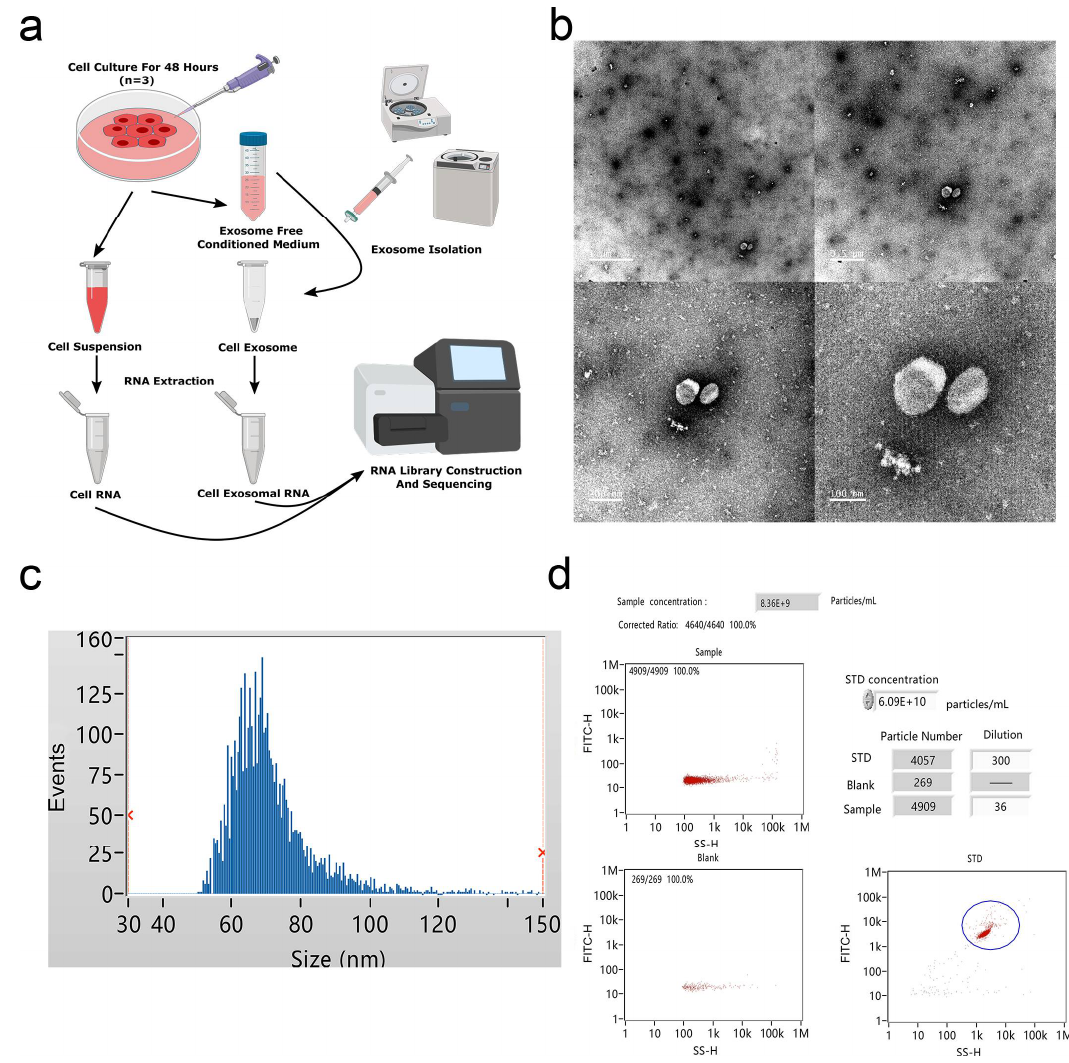
Figure 1. Identification of bovine adipocytes-derived exosomes. ( a ) Exosome collection procedure from bovine adipocytes conditioned medium. ( b ) Transmission electron microscope (TEM) images of exosome isolations using ultracentrifugation. Scale bar = 1 µ m, 0.5 µ m, 200 nm, and 100 nm. ( c ) The size distribution of the purified exosomes was detected using Flow NanoAnalyzer. ( d ) Analysis of exosomal concentrations corresponding to the data in ( c